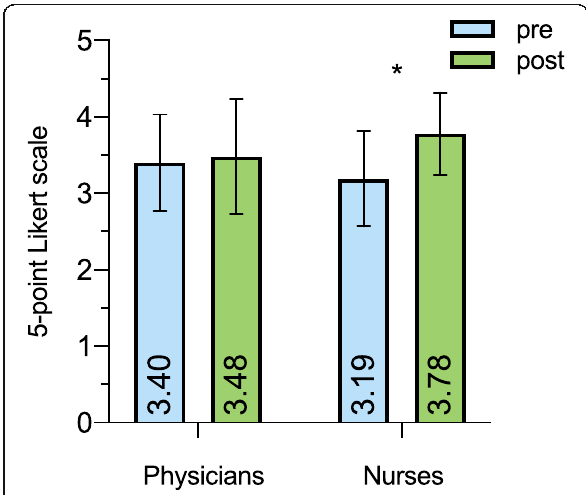
Fig. 2 Safety climate depending on profession. Mean values and standard deviation (SD) for perceived safety climate depending on profession are depicted for the pre- and post-interventional phase. Individual mean values are written vertical per column. The red lines reflect the proposed benchmark of 3.4 points. * indicating p <